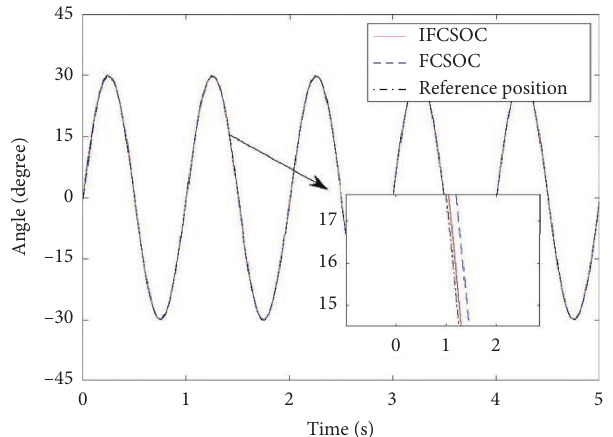
Figure 6: Tracking of the sinusoidal signal.